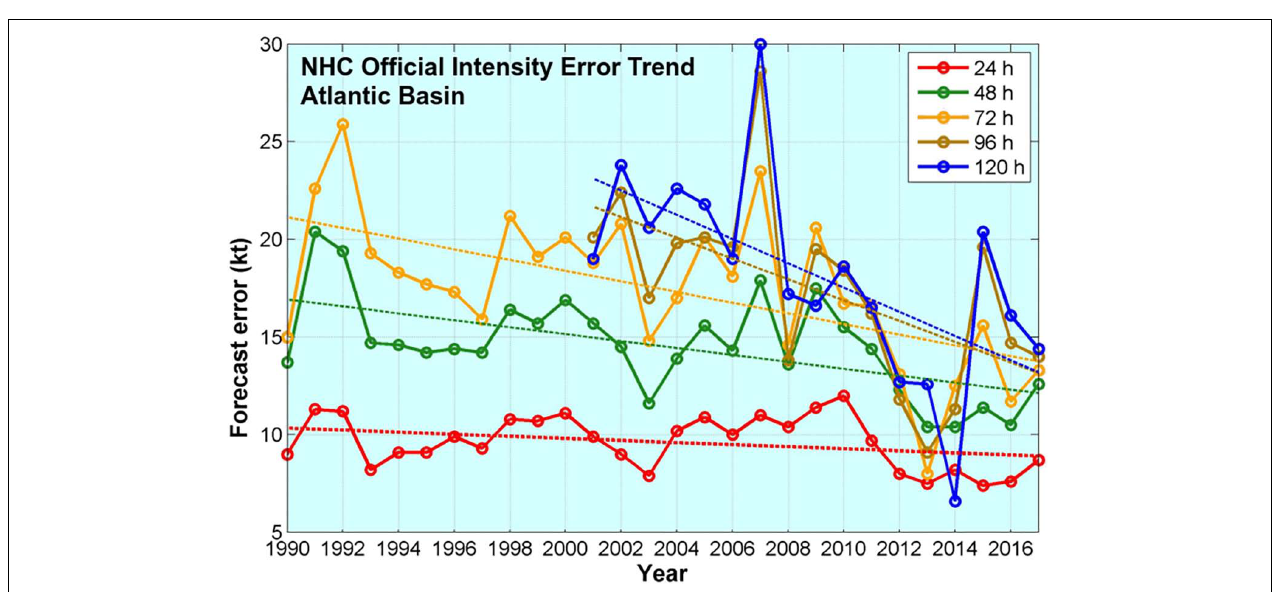
FIGURE 3 | Official Atlantic hurricane intensity forecast error for the Atlantic basin reported by NOAA’s National Hurricane Center. Source: https://www.nhc.noaa.gov/